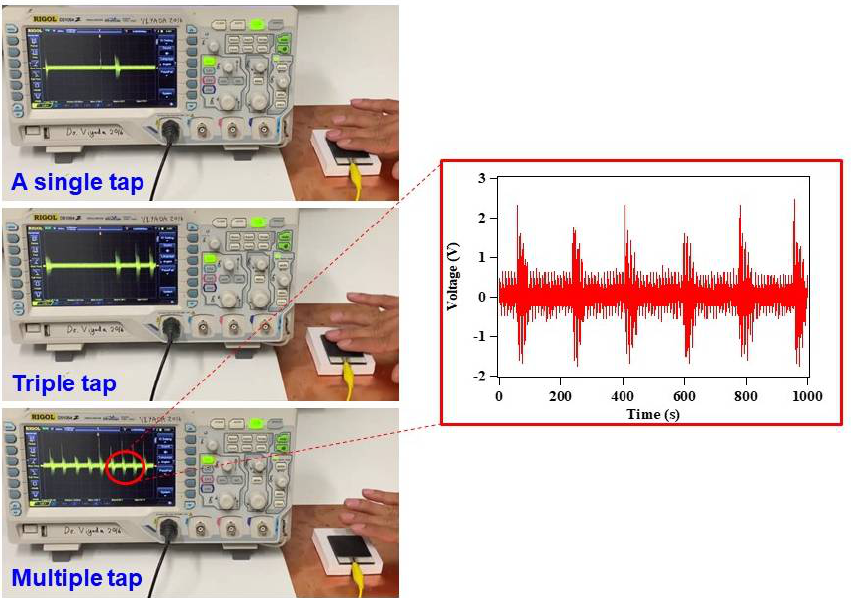
Figure 9. The demonstration of motion sensing application of the fabricated NR-ACH TENG under a single electrode configuration using finger taps and the inset of the generated voltage signal.